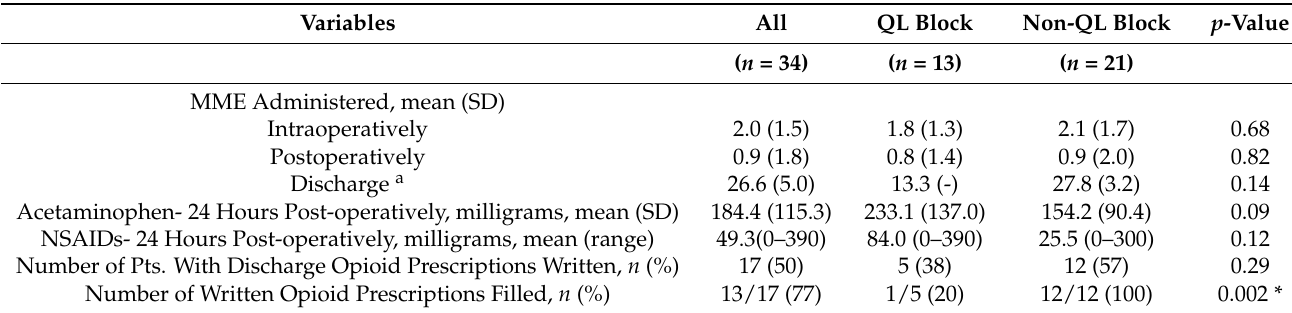
Table 2. Patient pain management outcomes ( n = 34).